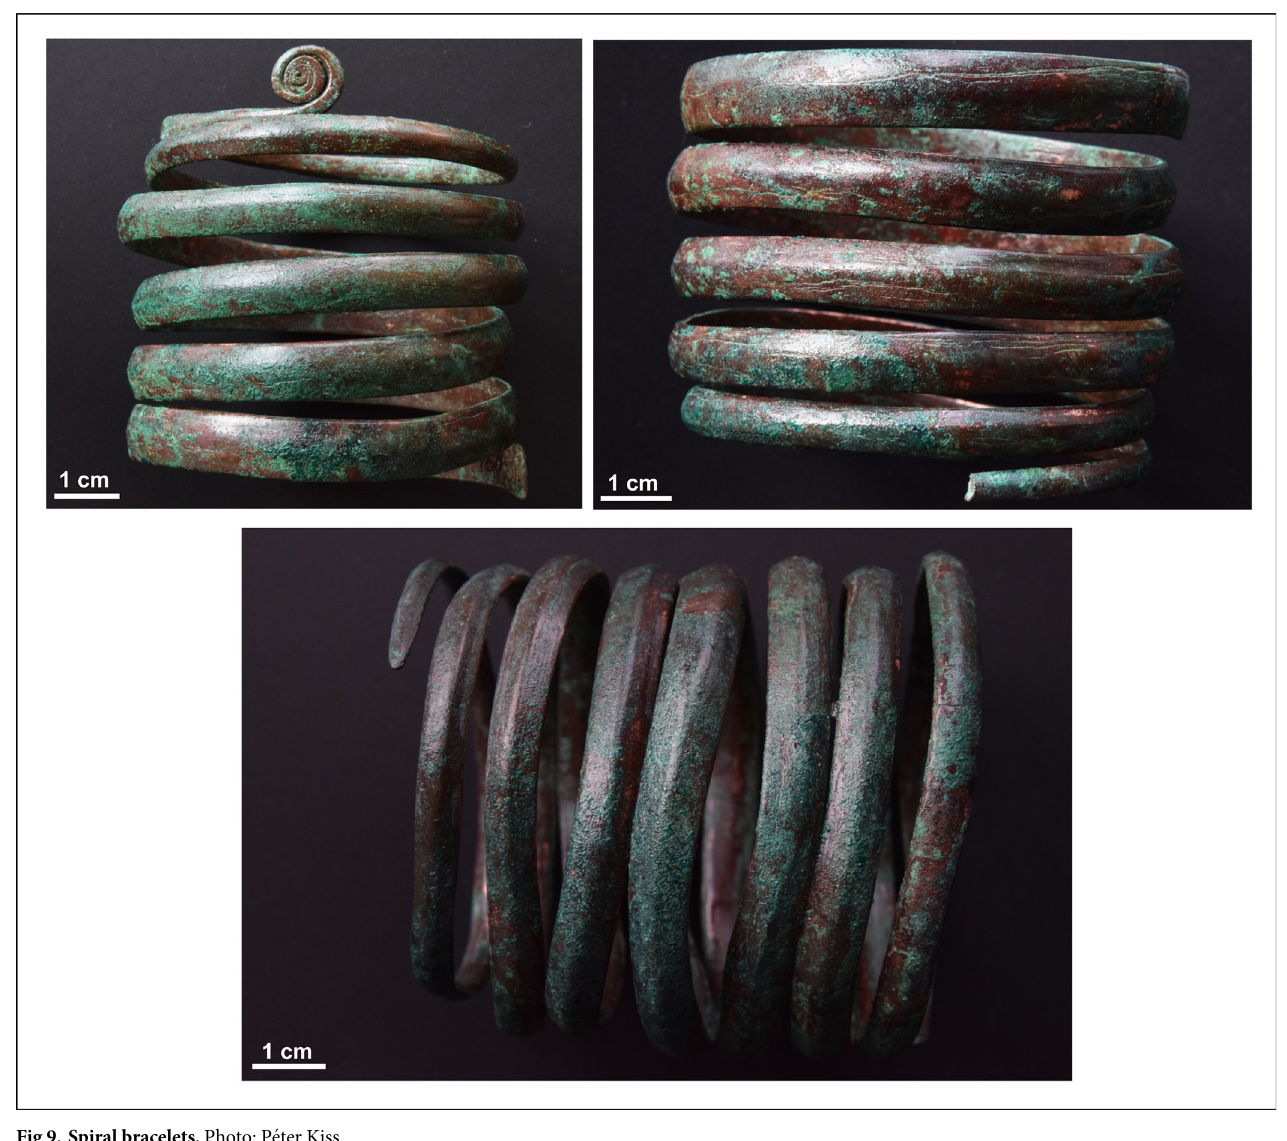
Fig 9. Spiral bracelets. Photo: Pe´ter Kiss.